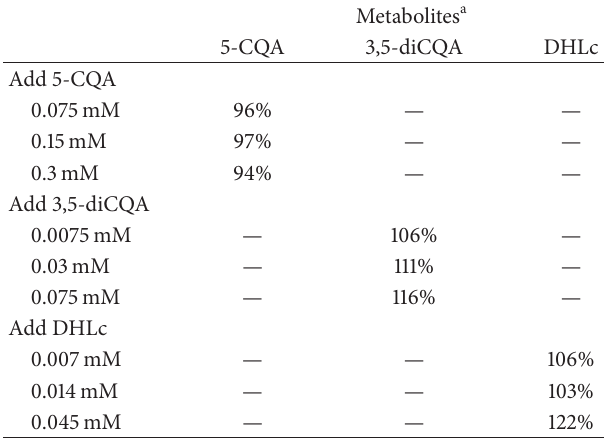
Table 5: Recovery (%) of the extraction of H 30/30/40 (v/v/v) with different additions (5-CQA, 3,5-diCQA, and DHLc) to flour.